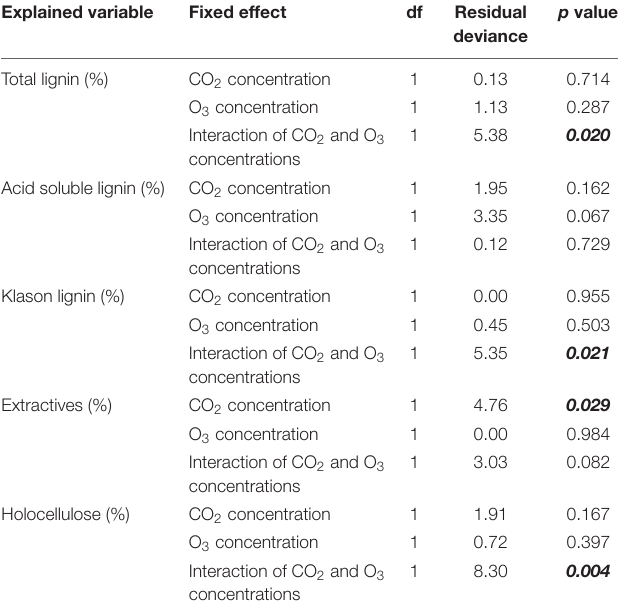
TABLE 3 | Results of the analysis of deviance (type II test) for the organic constituents of woody tissue. Explained variable